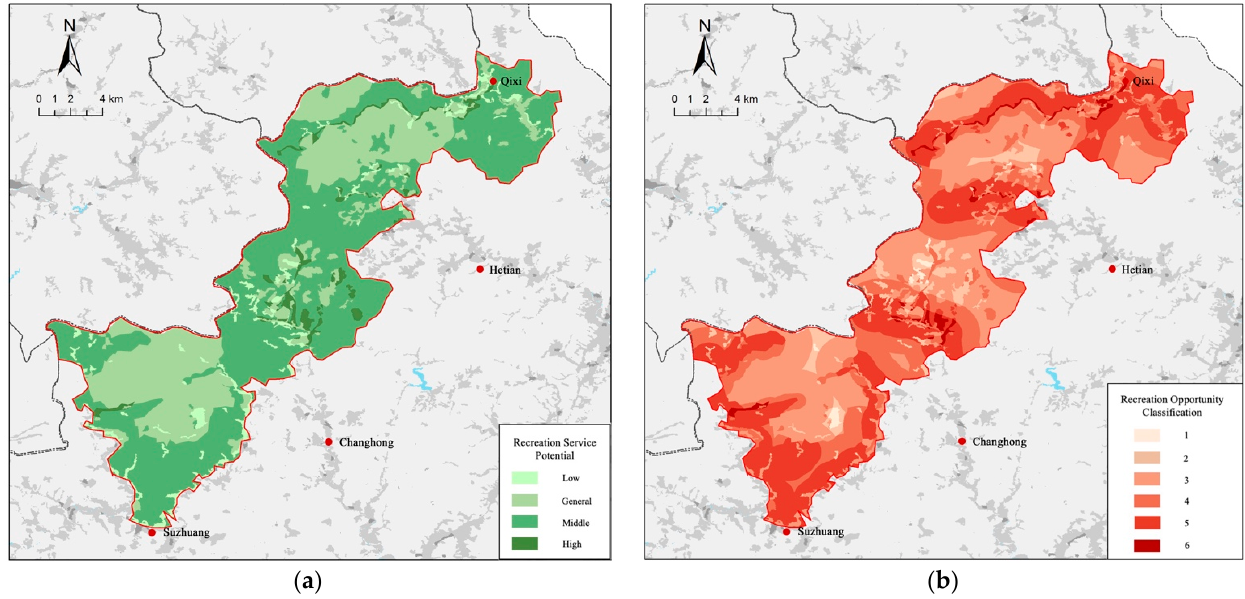
Figure 4. ( a ) The potential distribution of recreational services in Qianjiangyuan National Park; ( b ) Recreation Opportunity Spectrum of Qianjiangyuan National Park.